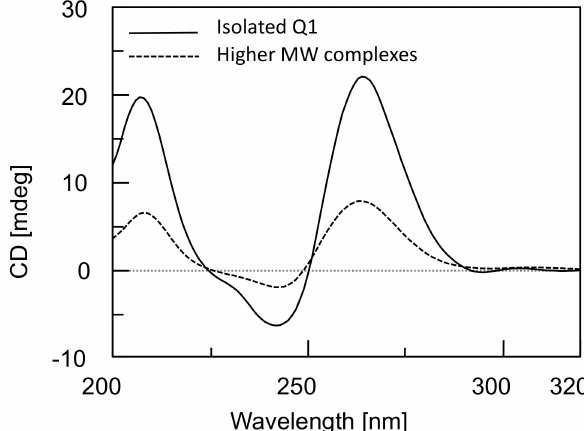
Figure 6. HPLC–SEC chromatograms of: ( A ) complexes formed by D2L ; ( B ) reinjection of the higher MW species formed by D2L collected as shown in panel A; ( C ) reinjection of the purified DEL-Q 1 complex formed by D2L collected as shown in panel A.